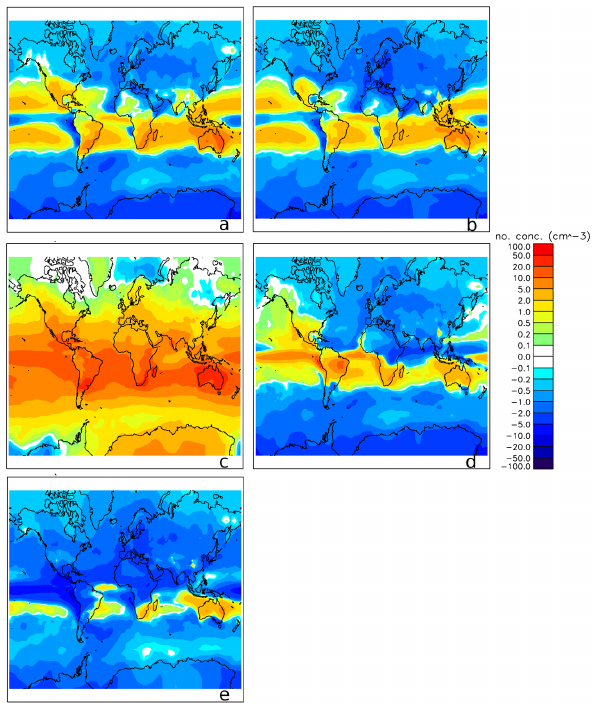
Fig. 8. Annual average difference in CCN concentrations ( > 35nm dry radius) at the surface for the different climatologies compared to the Kettle and Andreae (2000) climatology. (a) CLIM2 Sim´o and Dachs (2002) in PlankTOM5, (b) CLIM3 Vallina and Sim´o (2007) in PlankTOM5, (c) CLIM4 Anderson et al. (2001) in Diat-HadOCC (d) CLIM5 Sim´o and Dachs (2002) in Diat-HadOCC, (e) CLIM6 Vogt et al. (2009) in